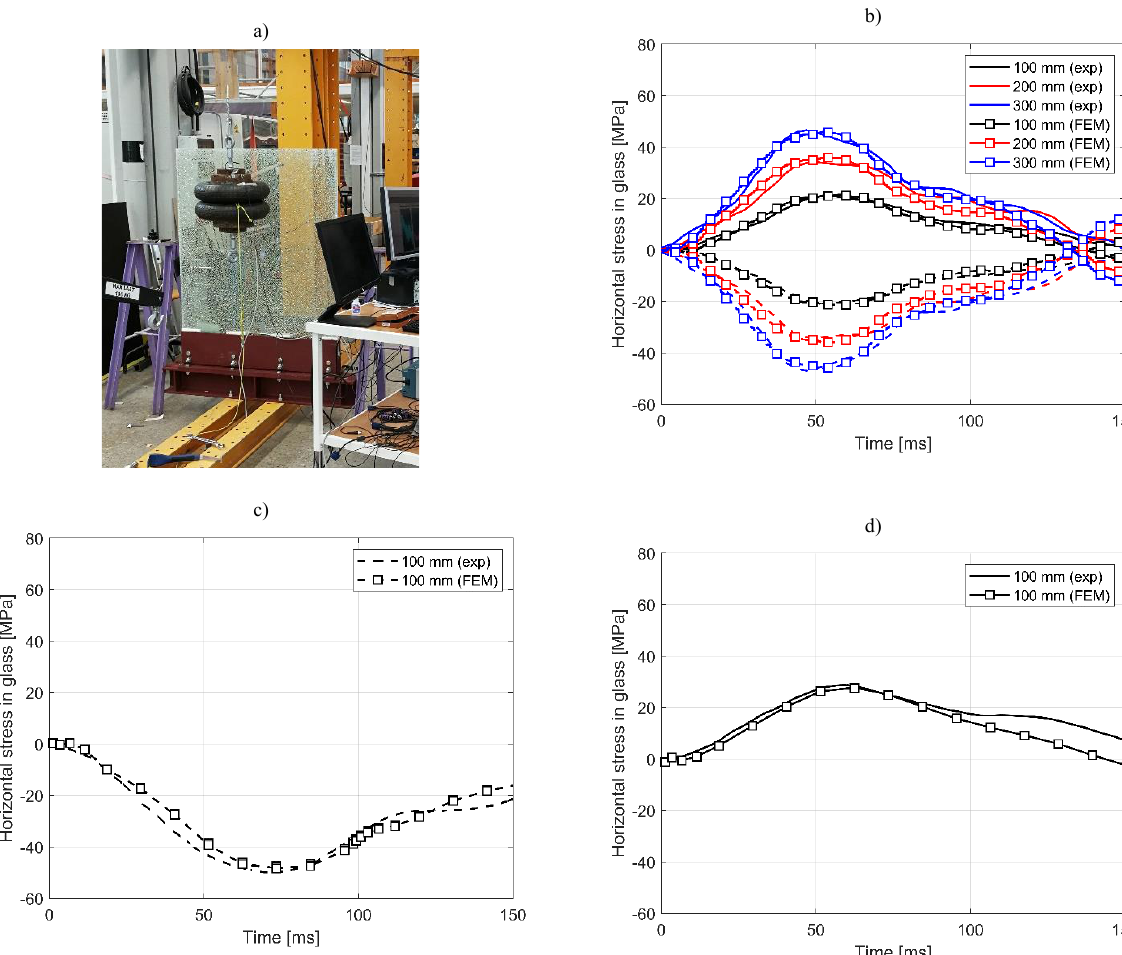
Fig. 7 Experimental results of soft-body impact for the laminated specimen type V: a) test set-up with fractured panel, b) comparison of numerical and experimental results in terms of stress in glass in the intact state, c) comparison of numerical and experimental results in terms of stress in glass in the fractured state (broken panel on pendulum side – strain gauge on tensile side was damaged, d) comparison of numerical and experimental results in terms of stress in glass in fractured state (broken panel on opposite side of pendulum - strain gauge on compression side was